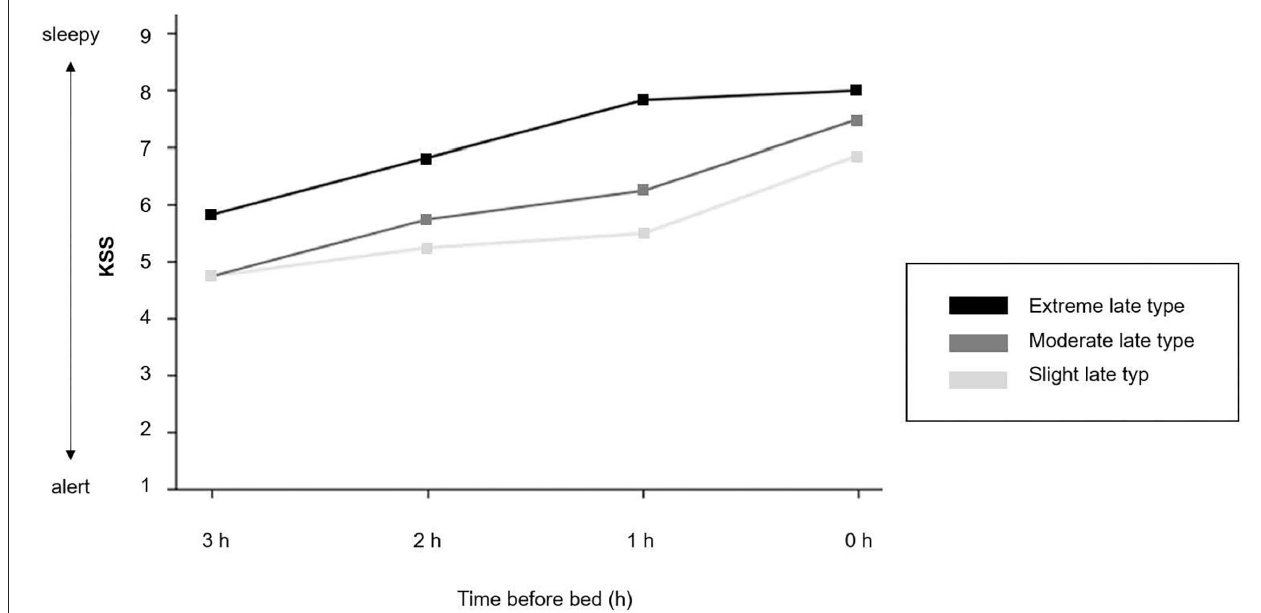
FIGURE 4 | Evening sleepiness. Time course of the Karolinska Sleepiness Scale (KSS) (mean values). 1 = extremely alert; 5 = neither alert nor sleepy; 9 = very sleepy, great effort to keep awake.